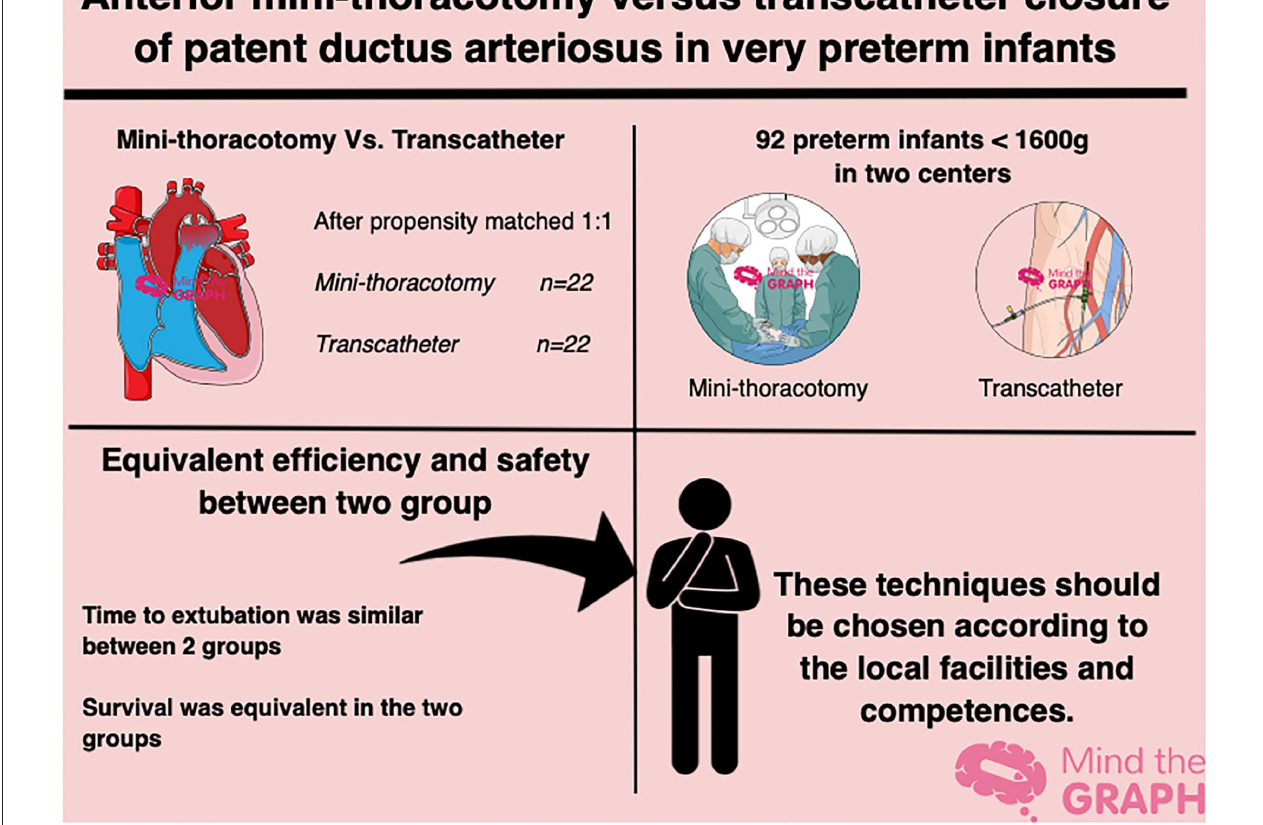
FIGURE 4 | Graphical abstract showing minithoracotomy vs. transcatheter in preterm infants < 1,600g with significant hemodynamic patent ductus